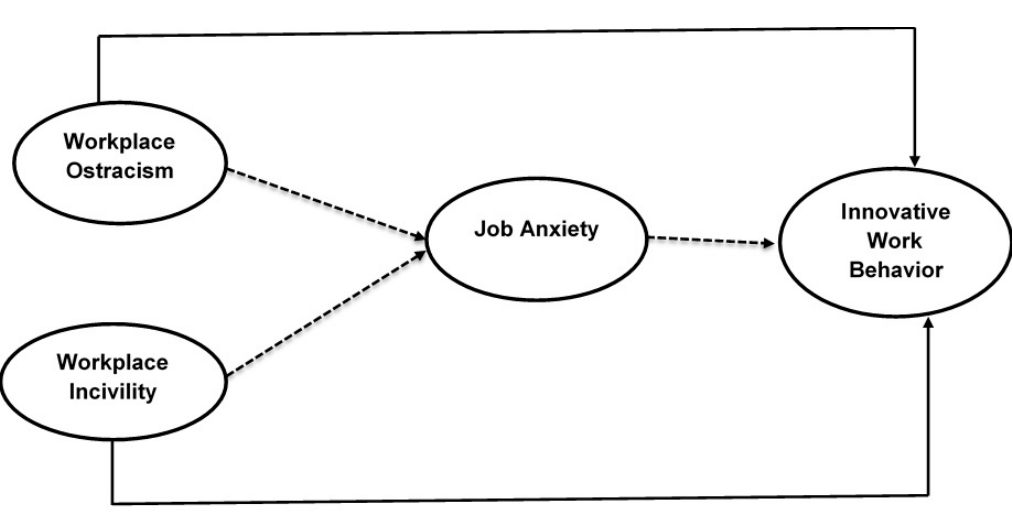
Figure 1. Proposed research model.